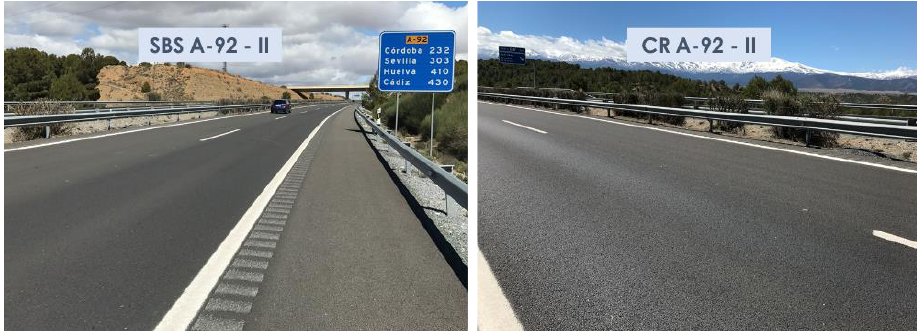
Figure 5. Aspects of the surface asphalt layers manufactured with SBS and crumb-rubber-modified binders on A-92 highway after 36 months of service life.